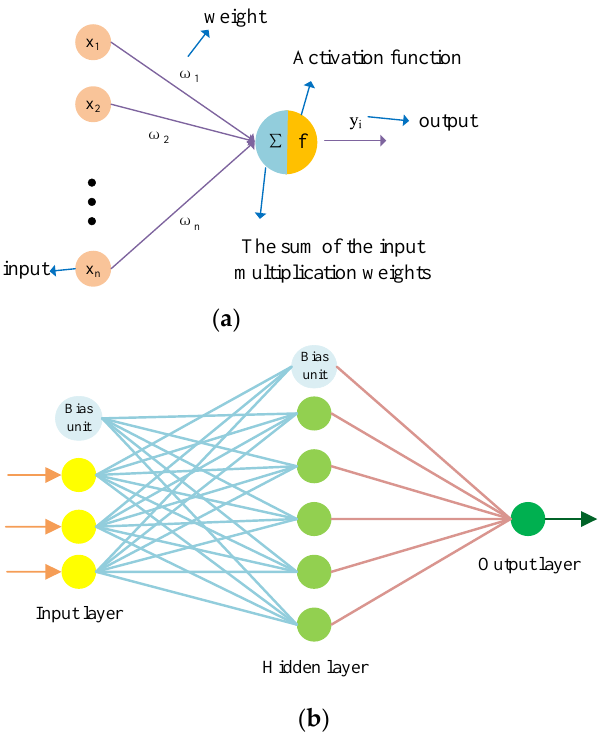
Figure 7. ( a ) The Specific Structure of BP Neural Network; ( b ) The Overall Structure of BP Neural